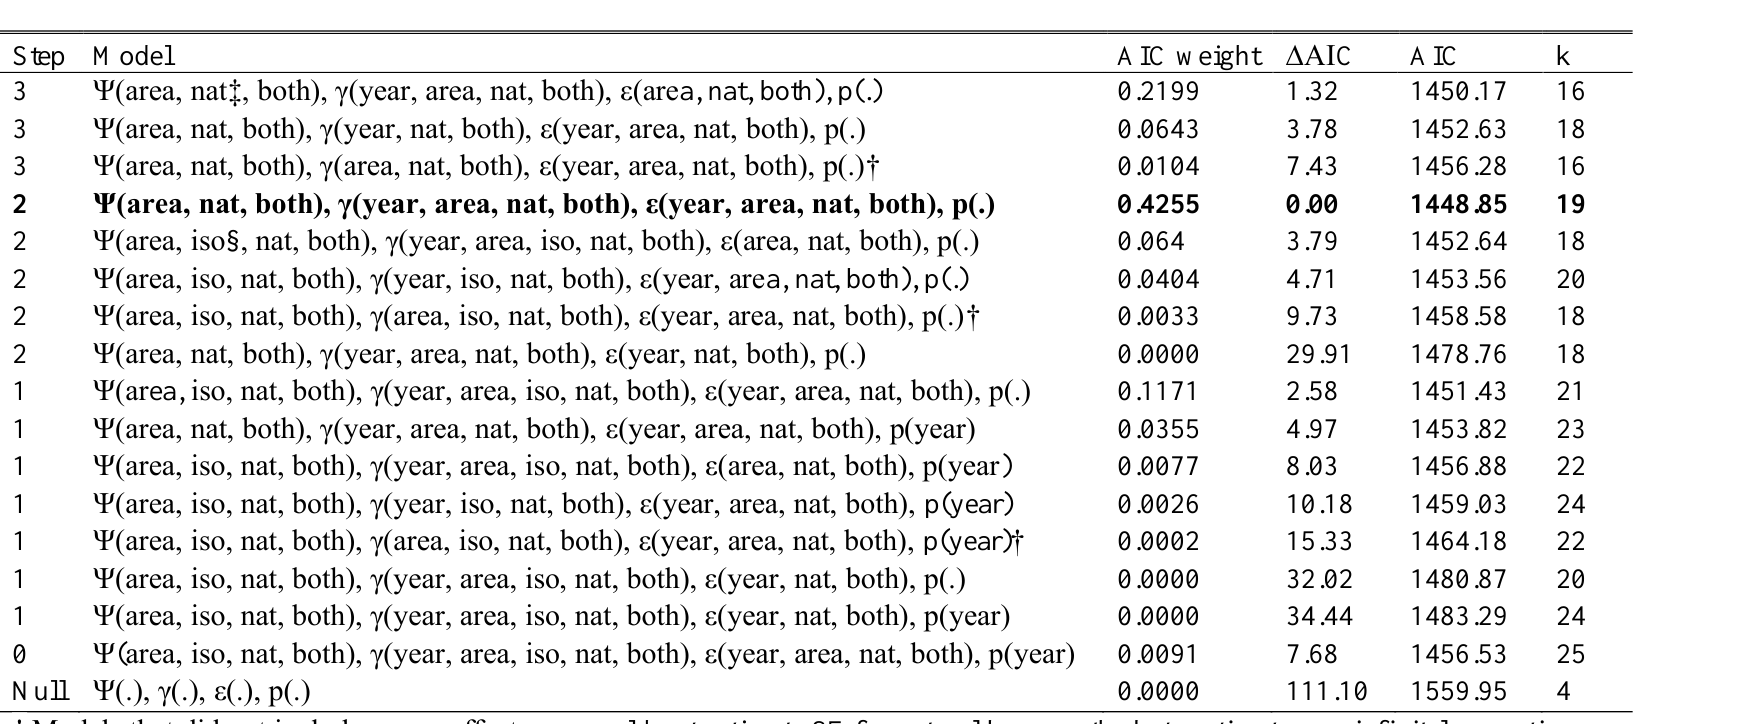
Table A1.3. Backwards stepwise AIC model selection table for a multi-season occupancy model for the Sierra Nevada foothills metapopulation of the California Black Rail ( Laterallus jamaicensis coturniculus ), 2012–2016. Starting with the full model (step 0), nuisance parameters (area, isolation, and year) were removed one at a time, and the lowest AIC was selected. The process was repeated until we found the lowest AIC (bold). Water source (natural, irrigated, or both; irrigated left out) was in all